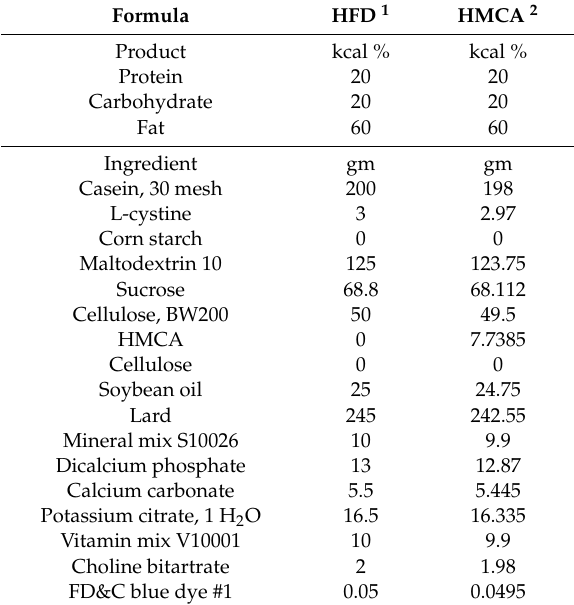
Table 1. Diet compositions.